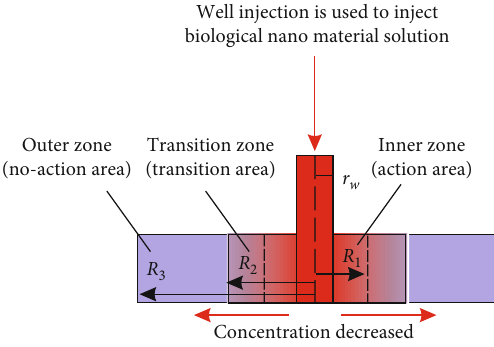
Figure 1: Schematic diagram of zoning